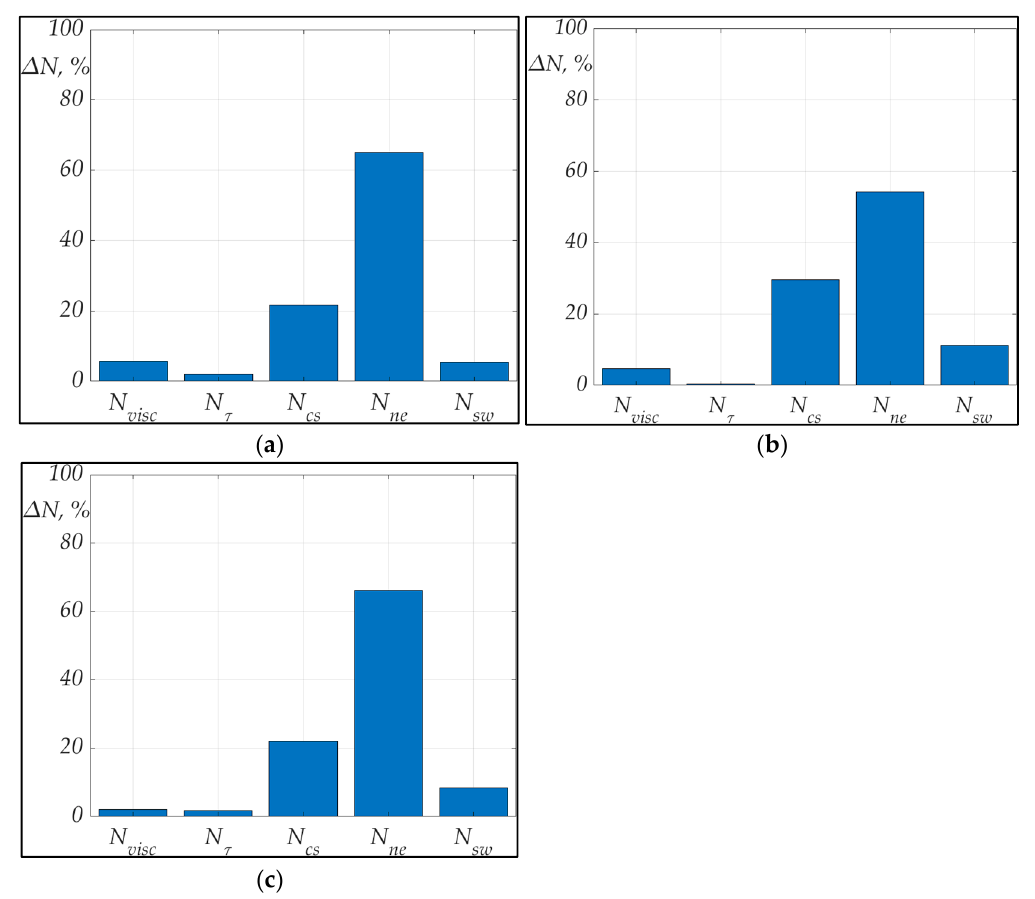
Figure 18. Power costs and losses distribution for ( a ) air ; ( b ) He ; and ( c ) CO 2 .